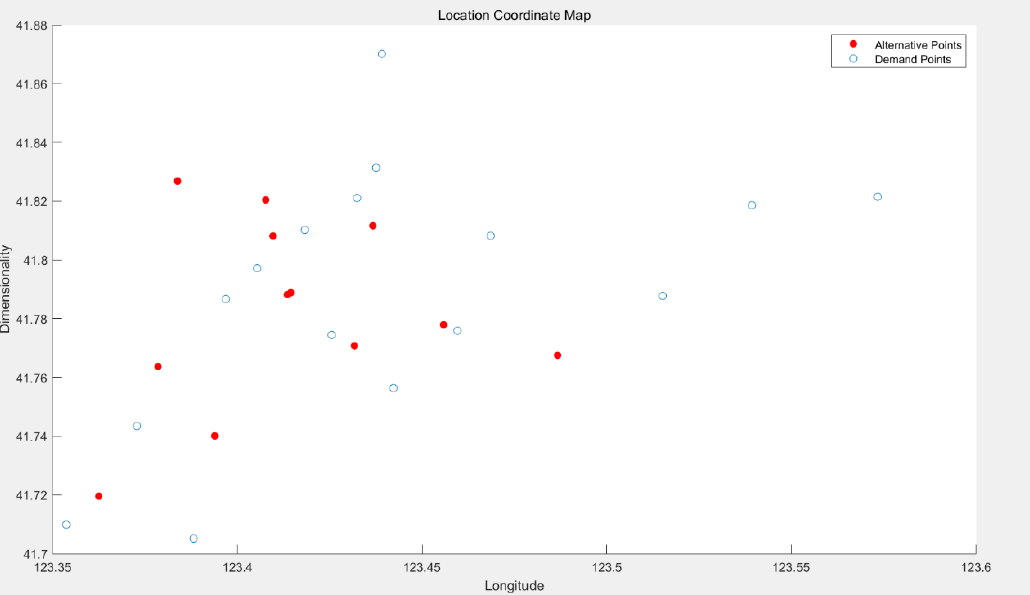
Figure 2. Coordinates of candidate points and demand points.